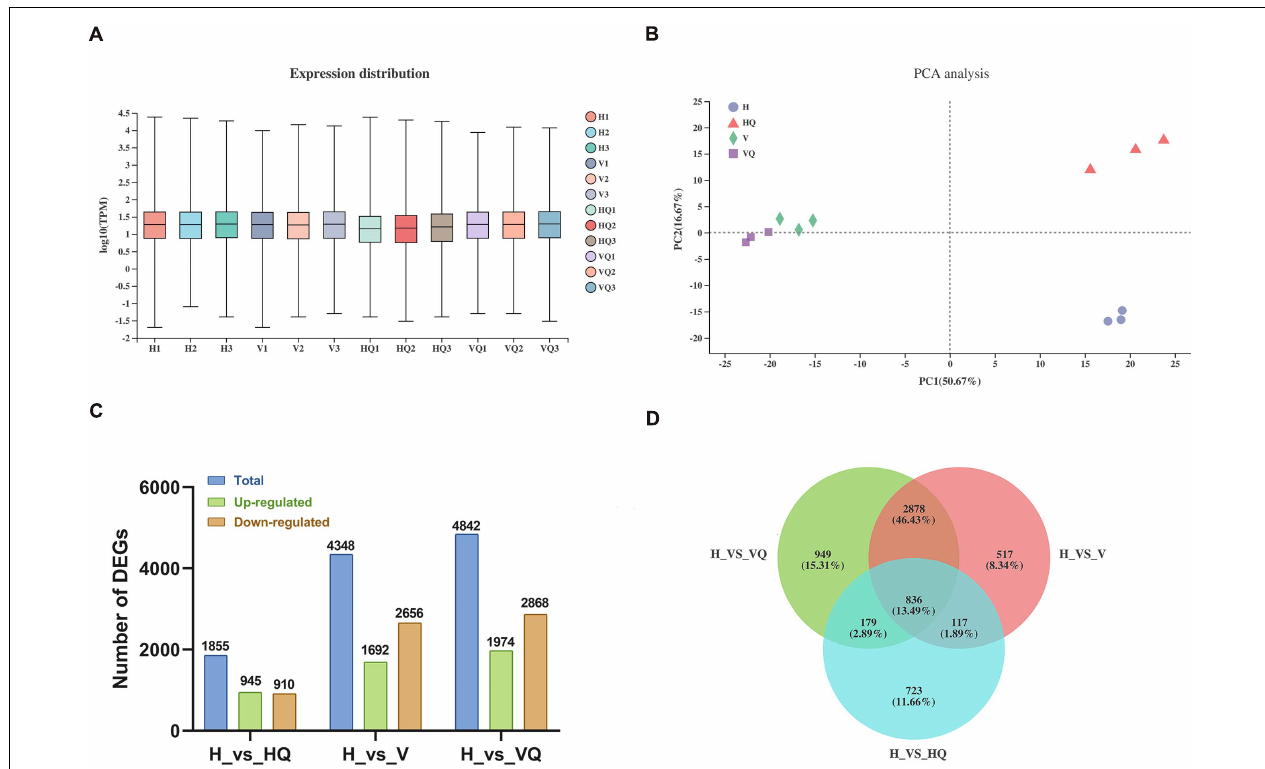
FIGURE 2 | Global gene expression profiling and principal component analysis in tomato plants under different treatment. H, healthy tomato plants. HQ, tomato plants was fed on by healthy B. tabaci for 24 h. V, tomato plants was inoculated with ToCV. VQ, tomato plants with ToCV that were fed on by healthy B. tabaci for 24 h. (A) Density plot of global gene expression in tomato plants under different treatments. (B) The degree of similarity between tomato plants samples under different treatments. (C) Up- and down-regulated differentially expressed genes (DEGs). (D) Venn diagram of